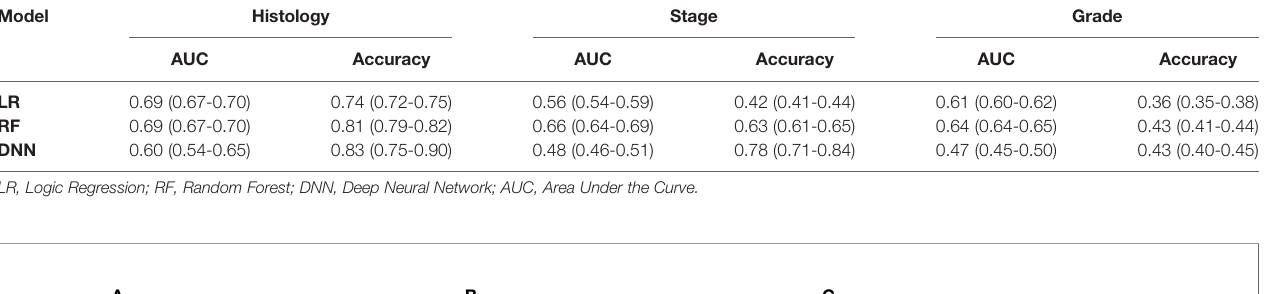
TABLE 3 | The AUC score and accuracy of three ML models for histology, stage, and grade prediction. Model